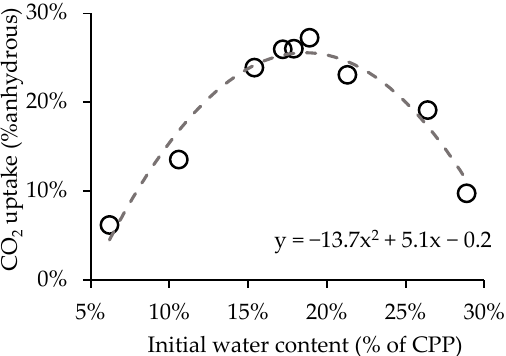
Figure 3. CO 2 uptake of CPP after 1 h for different initial water content.